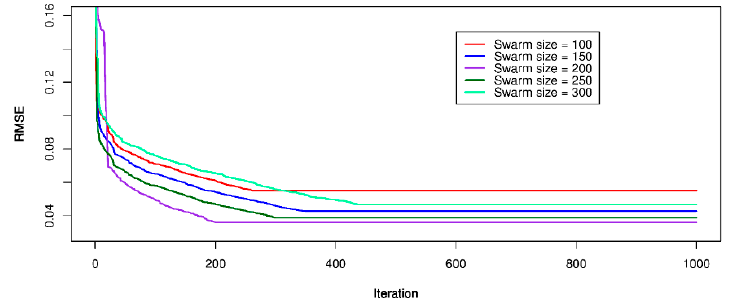
Figure 12. Performance of the PSO-SVR-L model on the training dataset.